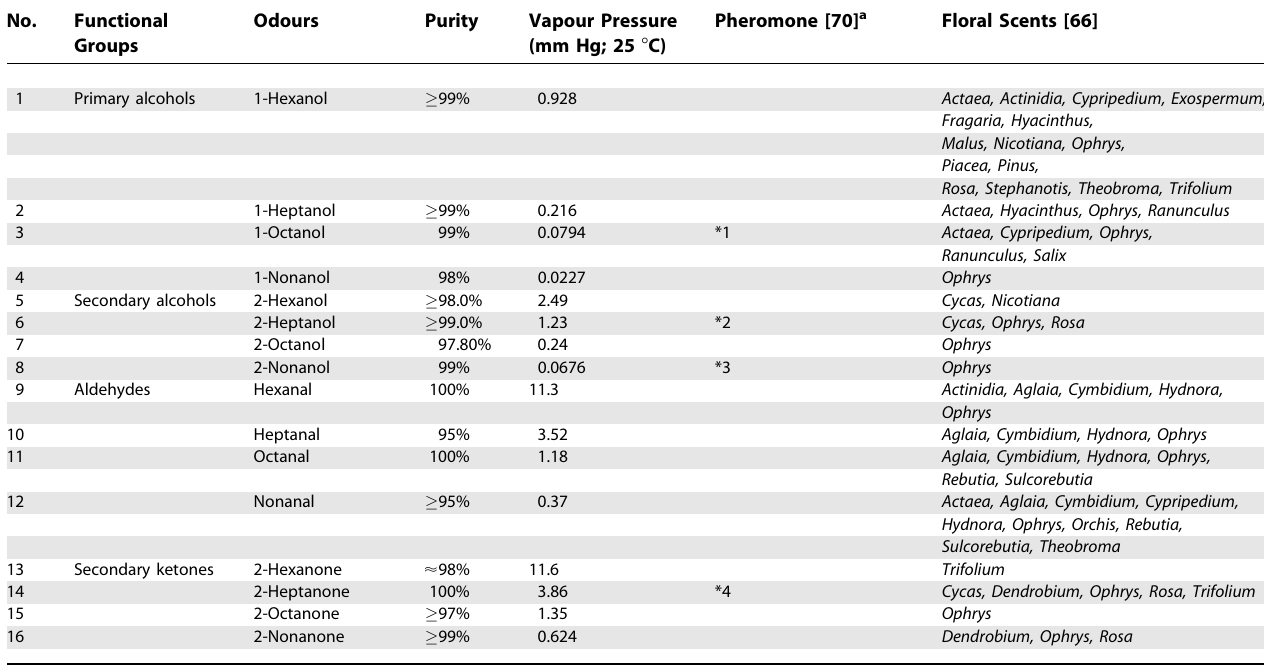
Table 1. Chemical and Biological Characteristics of the Odours Used